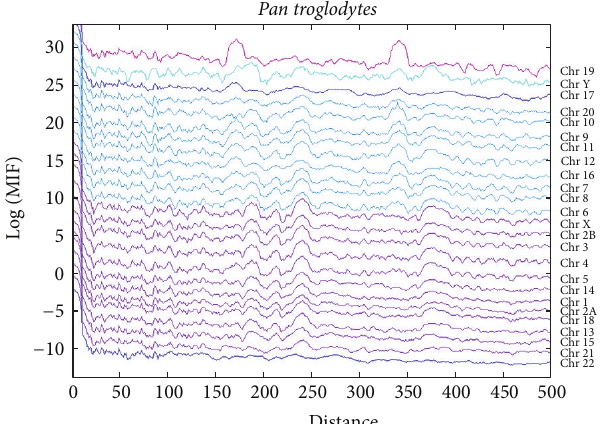
Figure8:TheMIFprofilesofthedecamerYYYYYRRRRRinall Pan troglodytes chromosomes.